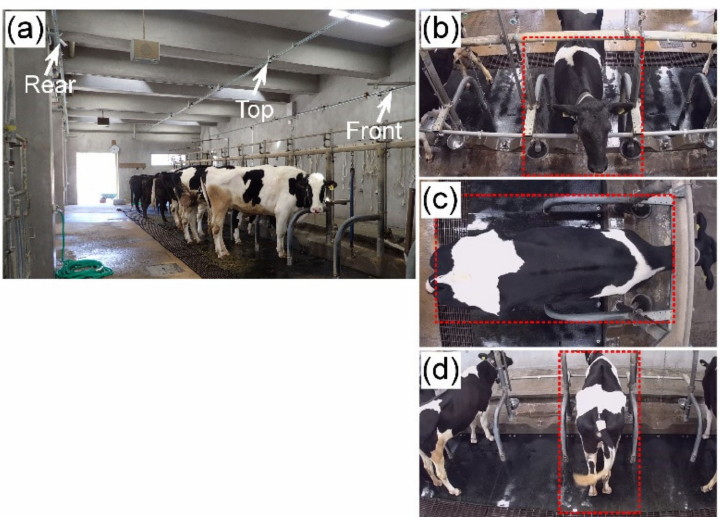
Figure 1. Position of webcams and example of captured frames. ( a ) Position of webcam. Three webcams were set up to capture the front, top, and rear views of the cow. The front-view webcam was placed 2.2 m ahead of the animal at a height of 3.3 m. The top-view webcam was placed 3.5 m above a tie-stall. The rear-view webcam was placed 2.7 m behind the animal at a height of 3.3 m. ( b – d ) Examples of frames captured by the front, top, and rear webcams, respectively. Red-dotted rectangles indicate regions of interest (510 × 640, 1000 × 540, and 350 × 720 pixels for the videos from the front, top, and rear webcams,